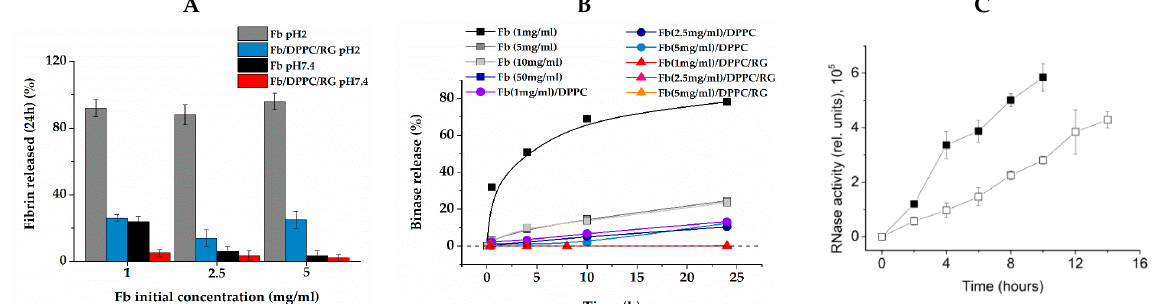
Figure 6. Release of fibrin (24 h of incubation, pH 2 and 7.4) ( A ); and dynamic of binase release ( Т ris–HCl рН 7.4) ( B ); from composite gels expressed as % of initial substances concentration in gel (Notice that data points for 1, 2.5 and 5 mg/mL Fb in composite Fb/DPPC/RG gels coincide). RG concentration is 1 mg/mL; ( C ) rise of binase activity in supernatant upon release from pure fibrin (closed symbols) and composite fibrin/DPPC (open symbols) gels ( Т ris–HCl рН 7.4, fibrin concentration 2.5 mg/mL).